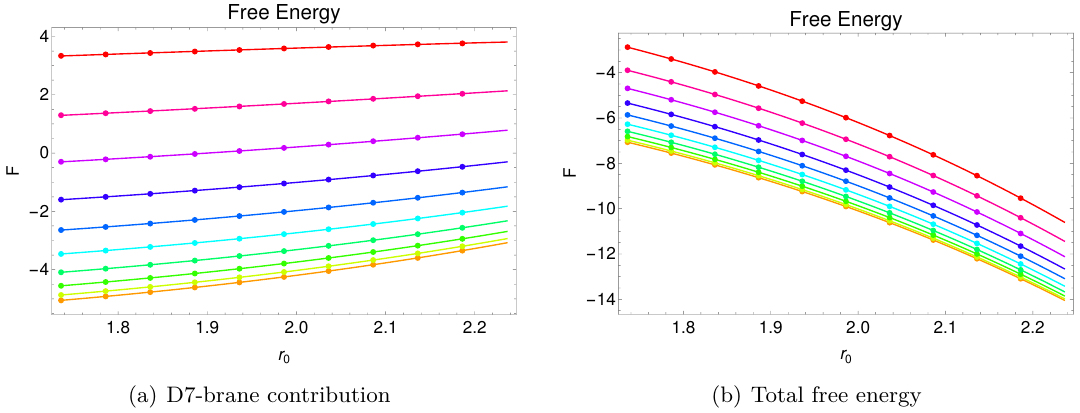
Figure 12 . Free Energy of cutoff branes in black hole background.